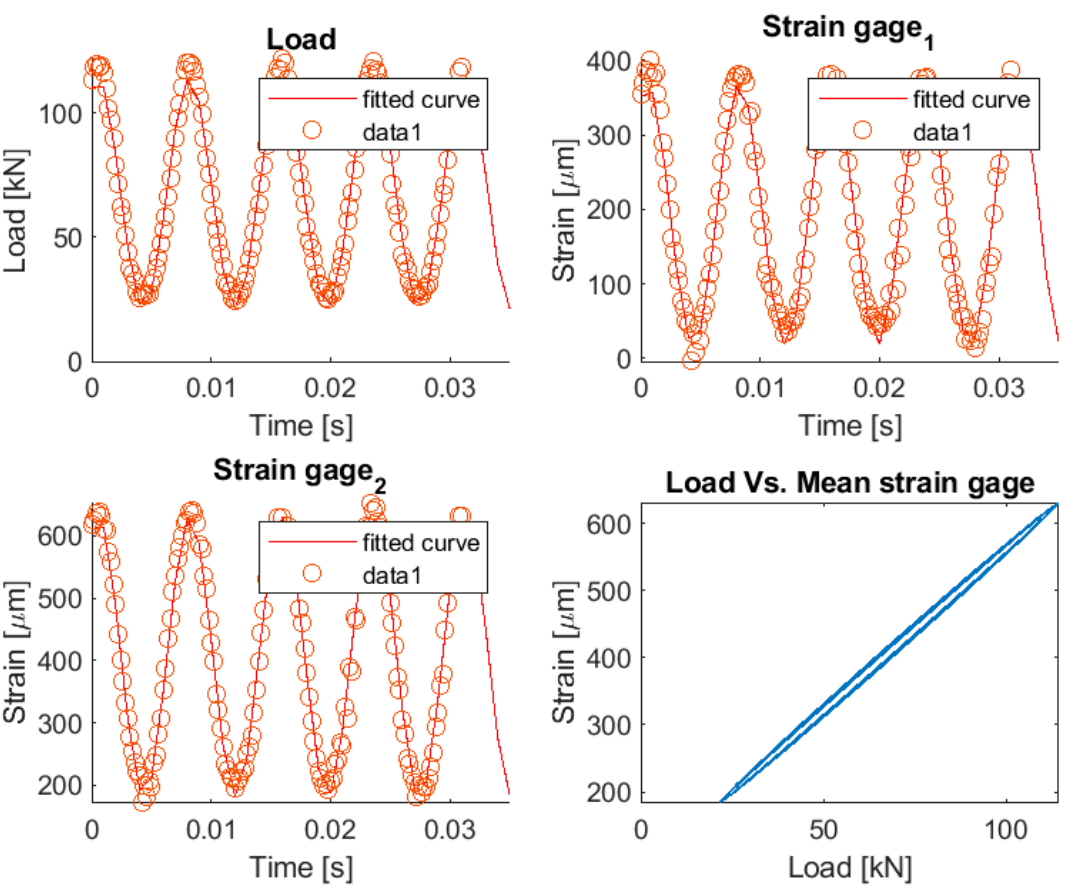
Figure 3. Example of the correlation between the recorded data and fitting values.